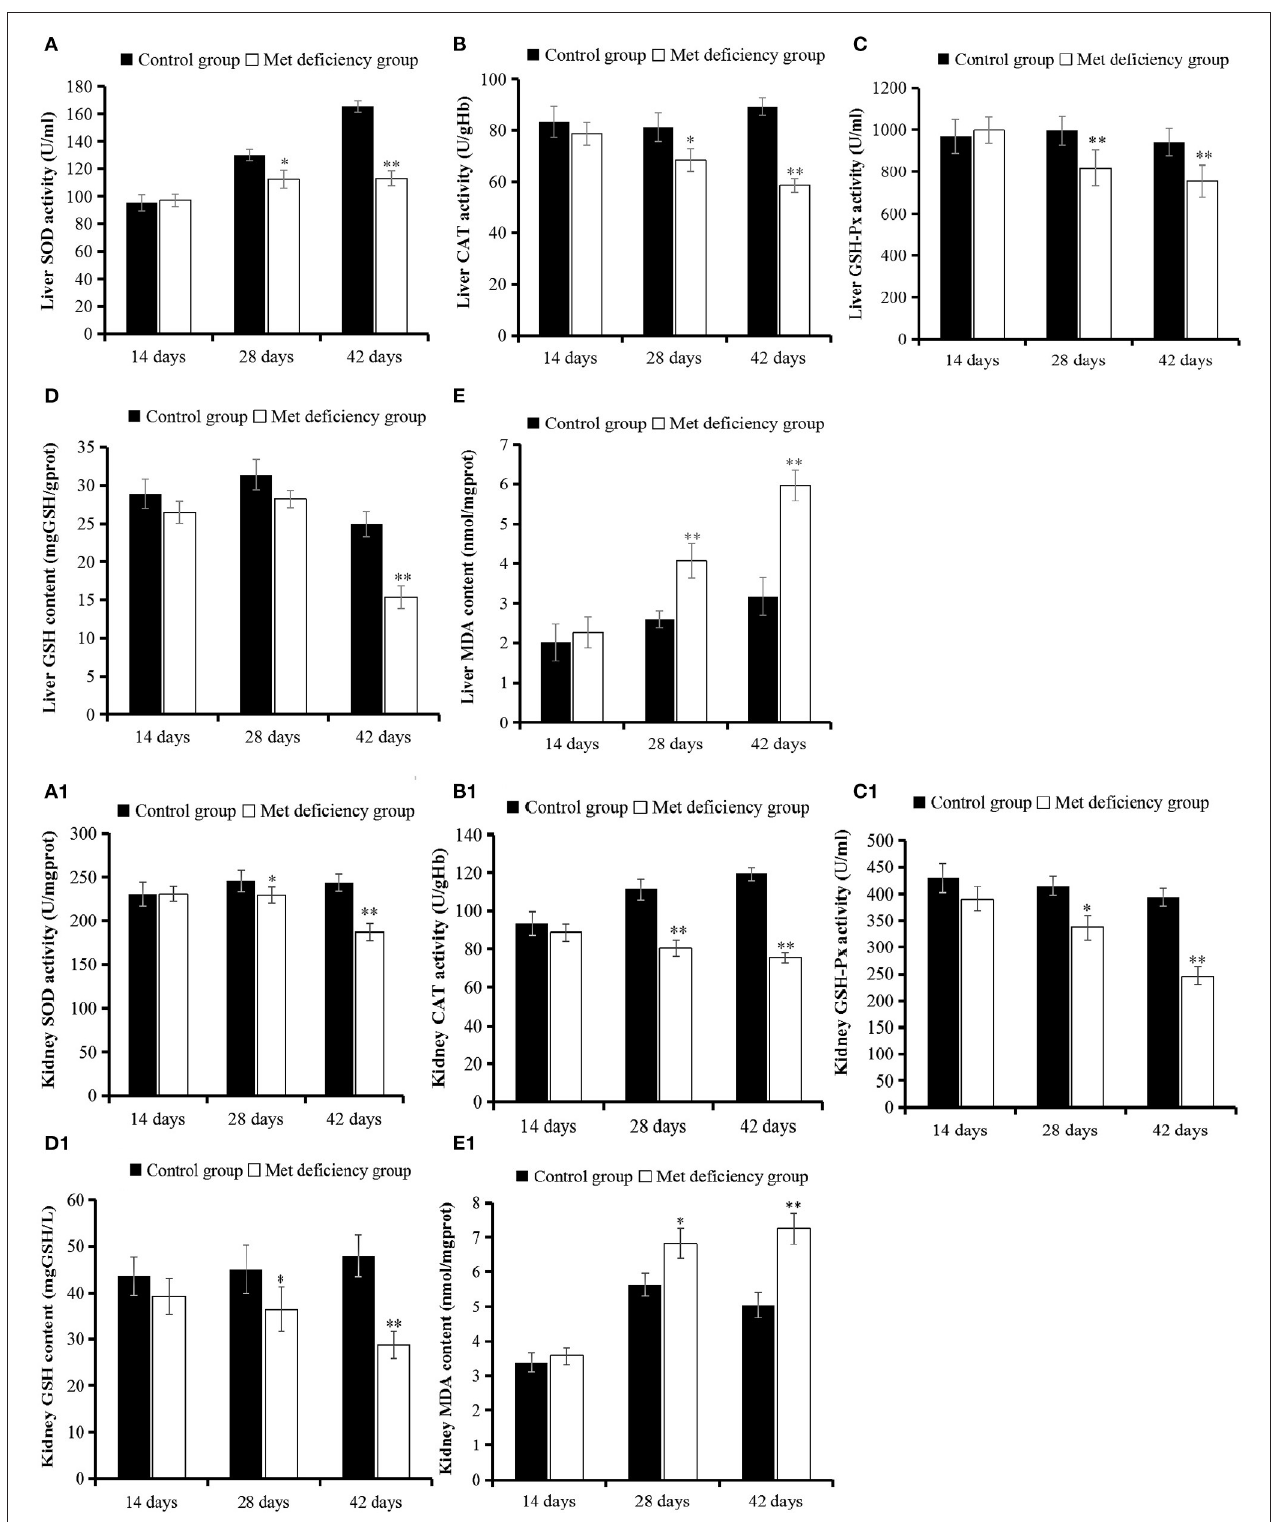
FIGURE 3 | Oxidative stress evaluation in liver and kidney. The activities of SOD, CAT, and GSH-Px in liver (A–C) and kidney (A1–C1) were all significantly ( p < 0.05 or p < 0.01) decreased at 28 or 42 days of age in the MD group compared to the control group. (D and D1) The level of antioxidant substrate GSH decreased in the MD group at 42 days of age compared to the control group. (E and E1) The level of oxidation product MDA increased significantly in the MD group at 28 or 42 days of age. SOD, superoxide dismutase; CAT, catalase; GSH-Px, glutathione peroxidase; MD, methionine deficiency; MDA, malondialdehyde; GSH, glutathione.